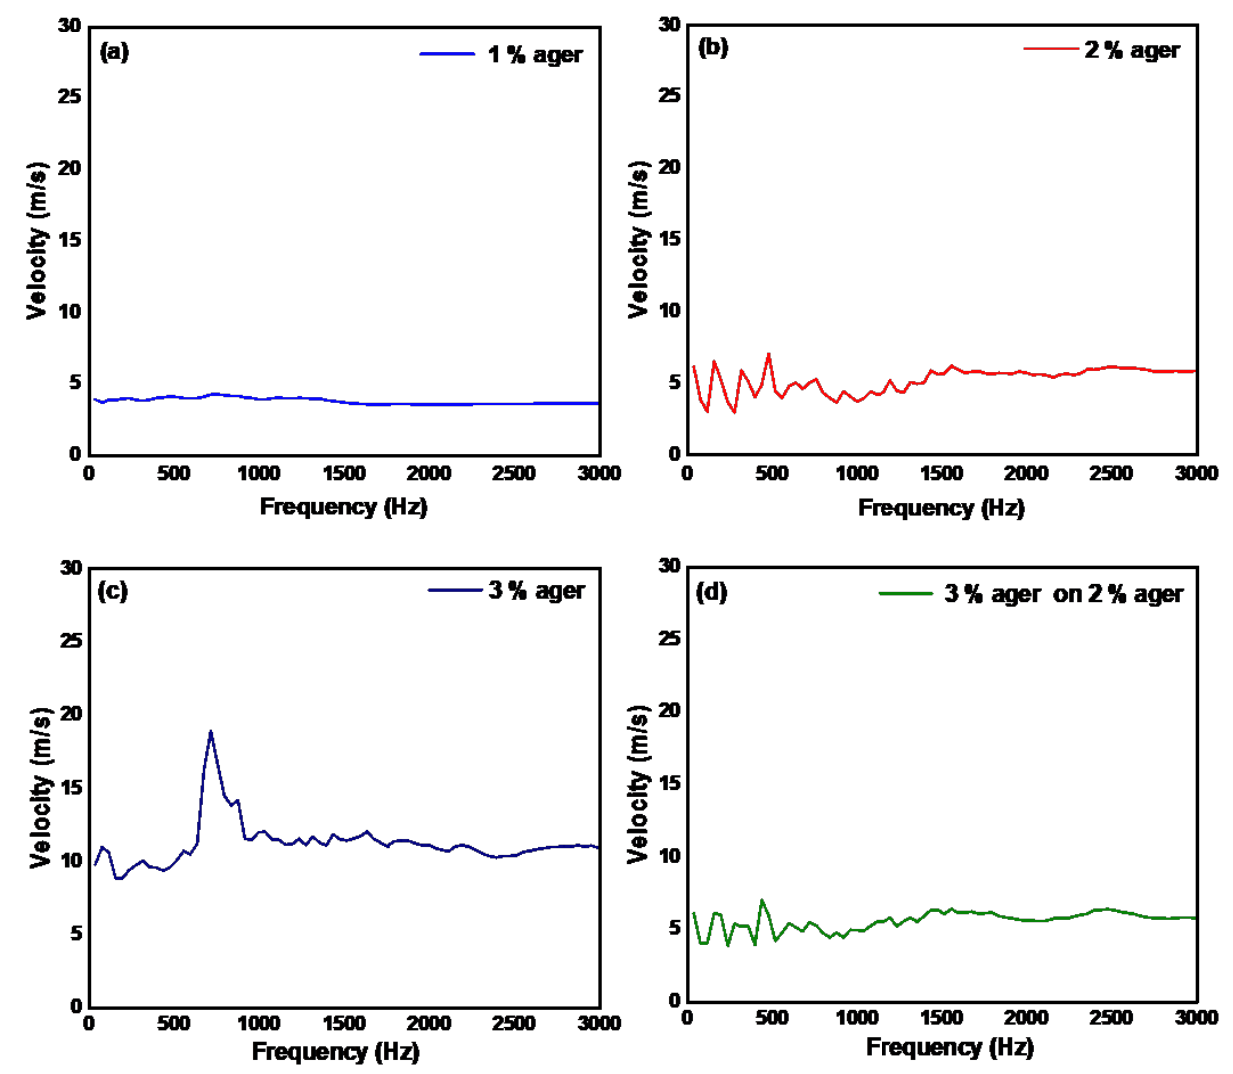
Figure 4. Surface acoustic wave velocity measured using continuous sine wave excitation method in ( a ) monolayer 1%, ( b ) monolayer 2%, ( c ) monolayer 3%, and ( d ) dual layer 3% on 2% ager phantom.